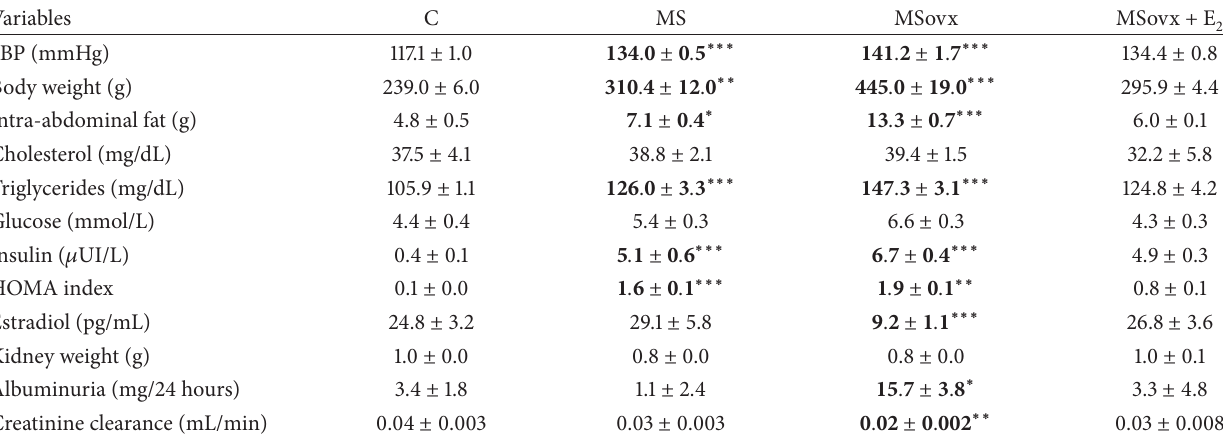
Table 1: General characteristics in experimental